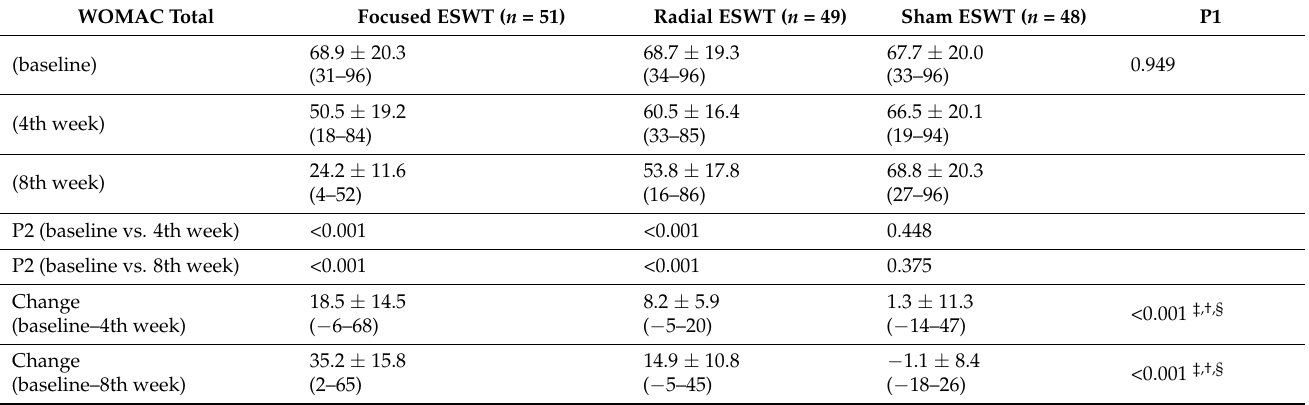
Table 6. Statistical analysis for the WOMAC total